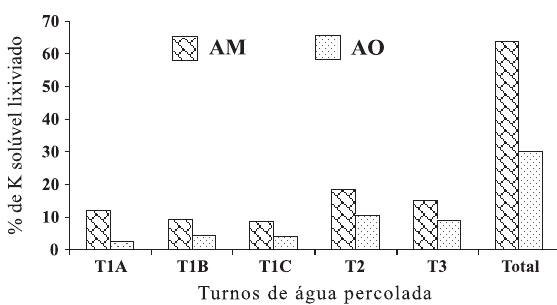
Figura 1. Percentagem (%) de K solúvel lixiviado através das colunas de solo, nos turnos de água percolada T , T , T , T e T , em relação ao 1A 1B 1C 2 3 total de K aplicado nos tratamentos adubo mineral (AM) e adubo